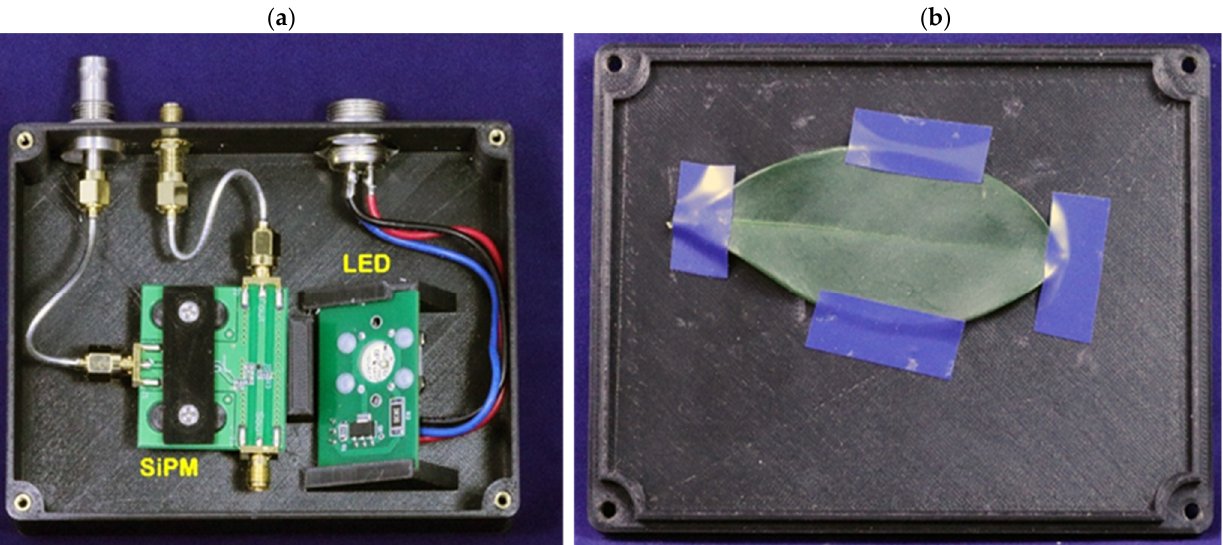
Figure 3. A photo of the inside of the chamber module having footprint: 9 cm × 12 cm. ( a ) Chamber base with the SiPM and interchangeable LED; ( b ) Chamber lid with the sample leaf adhered using non-fluorescent tape.